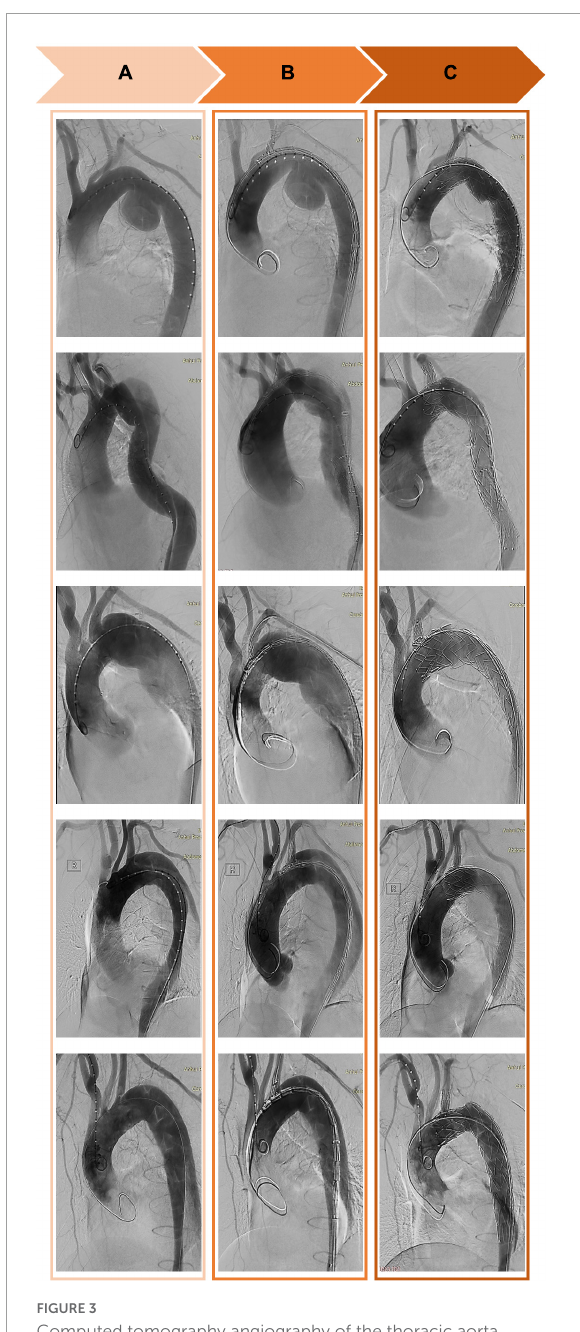
FIGURE3 Computed tomography angiography of the thoracic aorta before (A) , during (B) , and after (C) implantation of a Castor single-branch stent